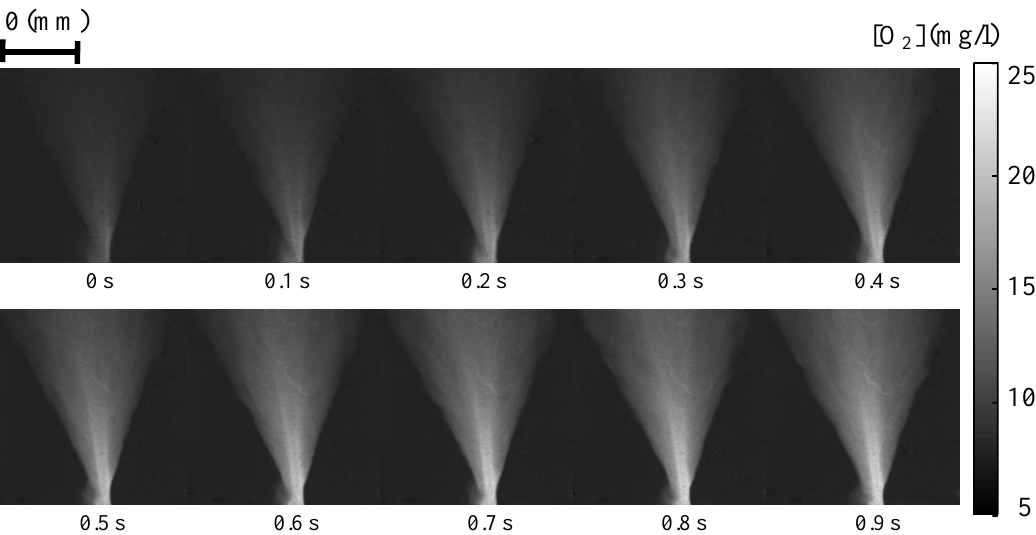
, (b) representative oxygen distribution image, I , and ref /I . ref